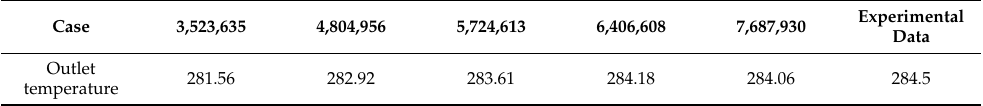
Table 1. Cases of mesh independence